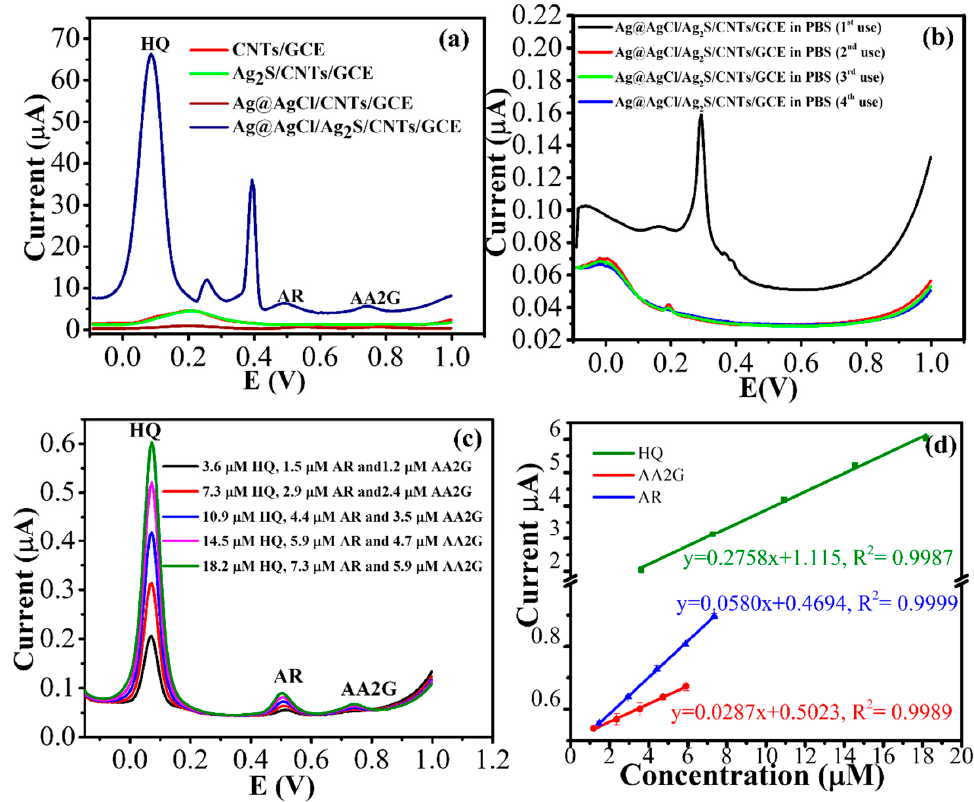
Figure 5. ( a ) DPVs obtained at CNTs/GCE, Ag 2 S/CNTs/GCE, Ag@AgCl/CNTs/GCE,